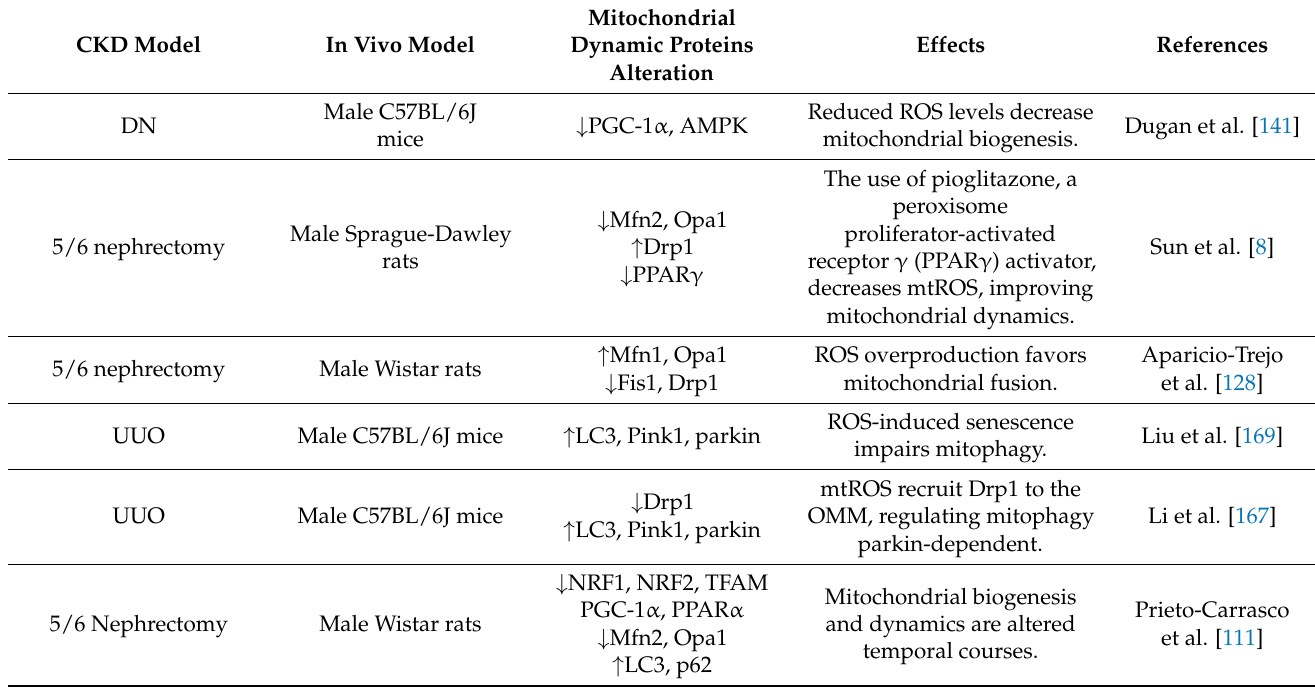
Table 2. ROS regulate mitochondrial dynamics, biogenesis, and mitophagy in chronic kidney disease (CKD) models.